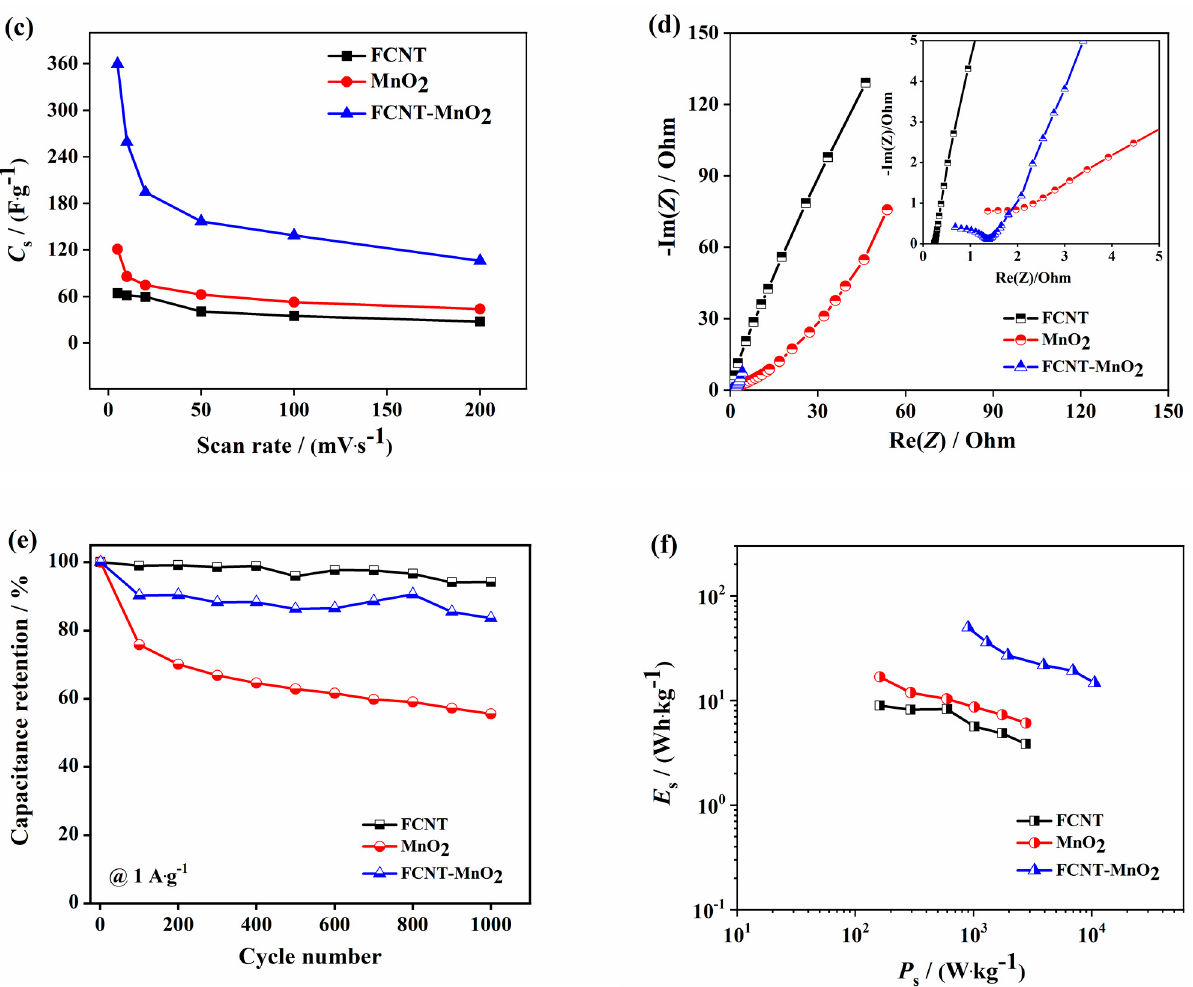
Figure 3. Comparison of electrochemical performance of FCNT, MnO 2 , and FCNT-MnO 2 in a two-cell configuration with 3 M KOH electrolyte ( a ) cyclic voltammetry at 10 mV · s − 1 , ( b ) galvanostatic charge-discharge curves at 0.5 A · g − 1 , ( c ) specific capacitance from CV, ( d ) EIS-Nyquist plot with inset showing the same in higher frequency region, and ( e ) Cyclic performance up to 1000 cycles from GCD at 1 A · g − 1 , and ( f ) Ragone plot from CV.